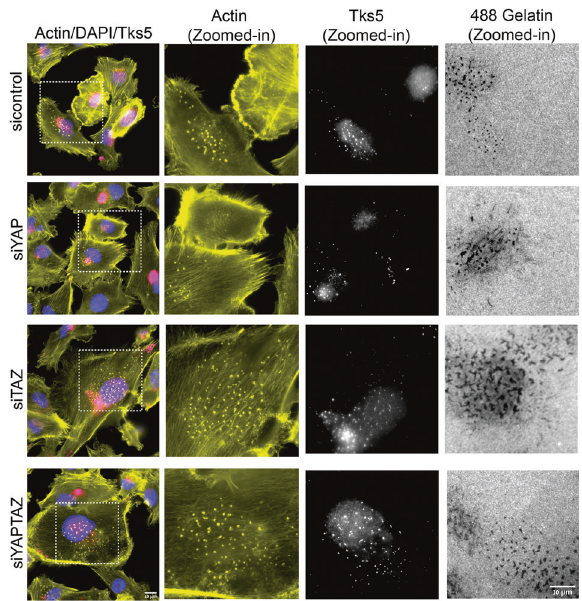
Fig. 4 Knockdown of YAP, TAZ or YAP + TAZ in MDA-MB-231 causes elevation in gelatin degradation and invadopodia. MDA- MB-231 cell lines were knockdown for siControl, siYAP, siTAZ and siYAP + TAZ and incubated on Alexa Fluor 488-gelatin for 5 – 6 h. Cells were fi xed and stained for actin, DAPI, and invadopodia-speci fi c marker Tks5. Cells in the fi rst panel are marked with dotted line white boxes displaying actin (yellow), Tks5 dots (white) and corresponding dark gelatin degradation areas as zoomed-in images are